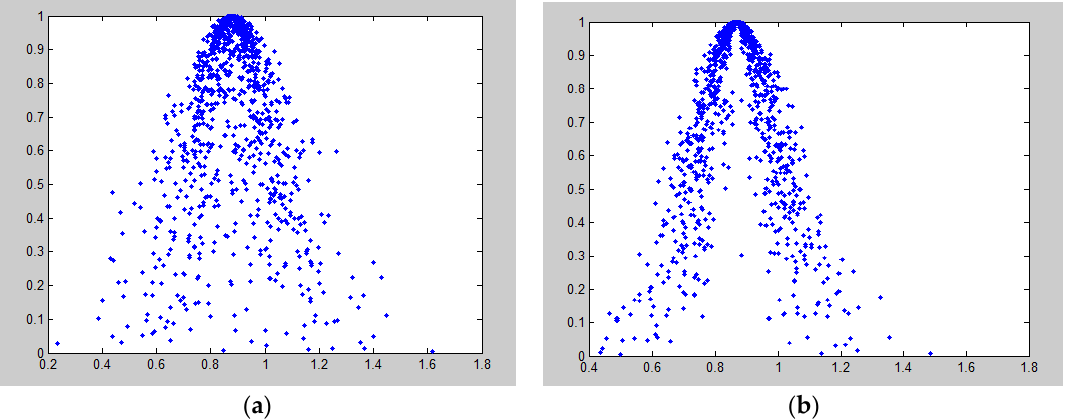
Figure 4. ( a ) The original cloud graph of attribute A 32 , ( b ) The updated cloud graph of attribute A 32 .